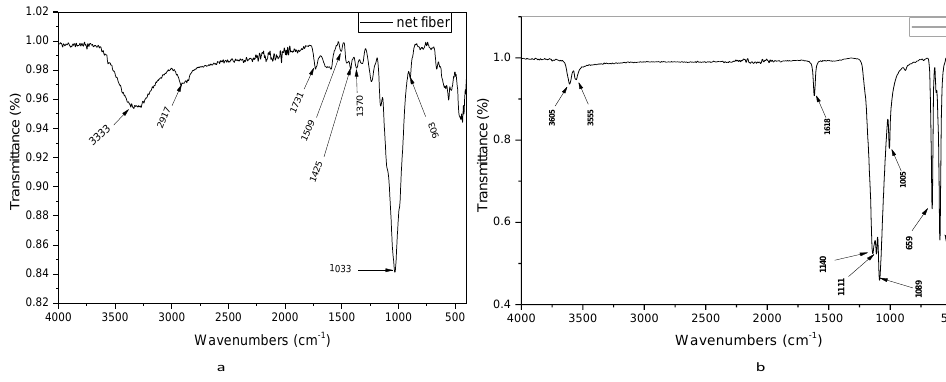
Figure 7. FTIR of: ( a ) Net Fiber; ( b ) plaster net.